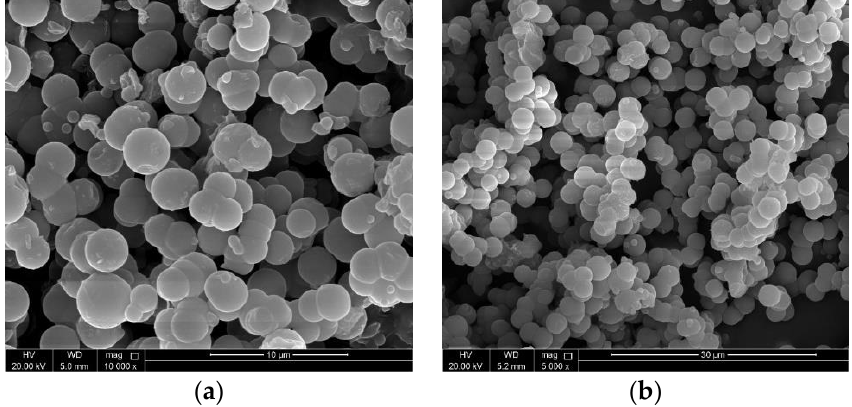
Figure 4. Trial-3 (1.50 g AOT) microcapsule SEM images for scales of ( a ) 10 µm and ( b ) 30 µm.